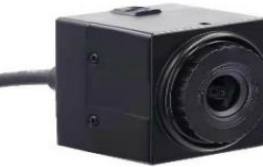
Figure 10. Image acquisition equipment.